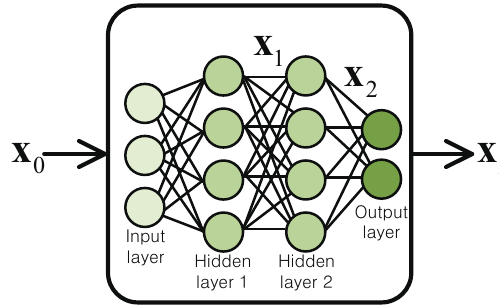
Figure 2. Fully-connected DNN with two ( L = 2) hidden